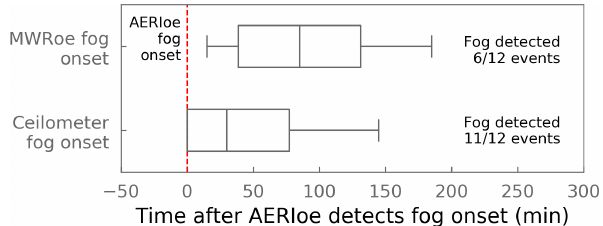
Figure 11. Time between fog onset detection from the AERIoe (ver- tical red line, t = 0) and fog onset detection from the MWRoe (up- per) and ceilometer (lower). Only cases where both methods de- tected fog are included (6/12 for the MWRoe and 11/12 for the ceilometer). The whiskers capture all data points; the box shows the interquartile